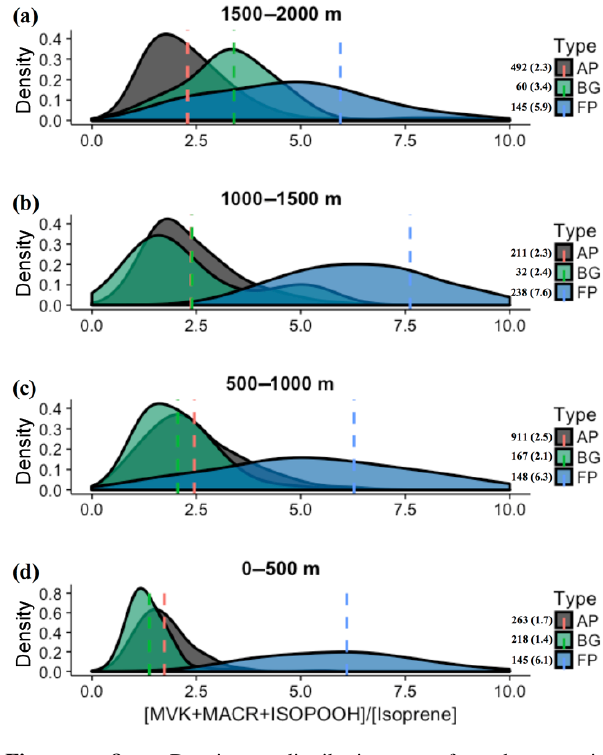
Figure 8. Density distributions of the ratio [MVK + MACR + ISOPOOH] / [isoprene], at the altitude layers (a) 1500–2000m, (b) 1000–1500m, (c) 500–1000m, and (d) 0–500m. The kernel analysis was carried out considering the classification for background (BG), aged smoke (AP), and fresh smoke plumes (FP). The number of samples and mean values for each group are depicted near the color